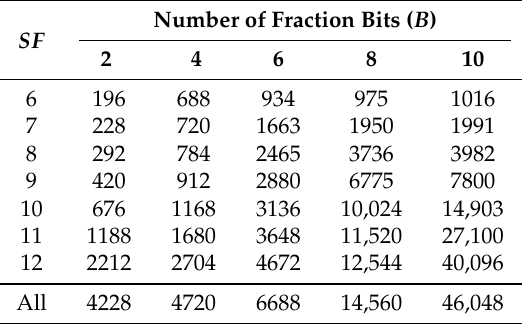
Table 6. Total number of samples ( N TX ) for a system with a length-81 filter, chirp segmentation, and